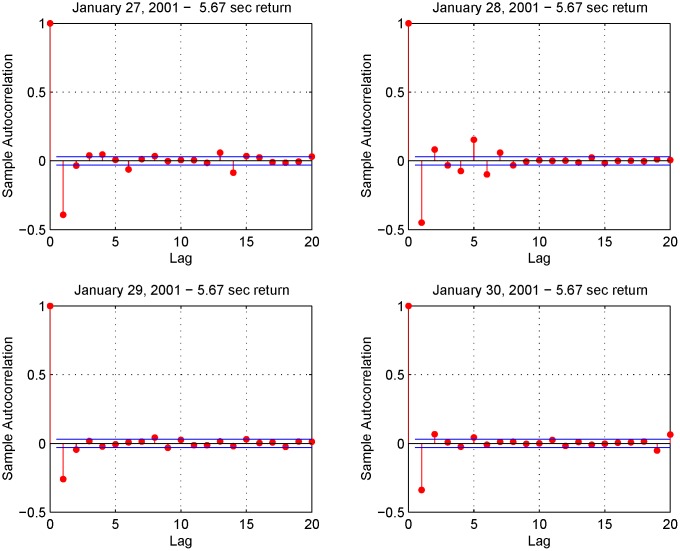
Autocorrelation functions.The four panels show the autocorrelation in 5.67-second returns on January 28-31, 2001.